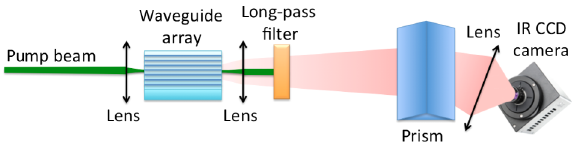
FIG. 6. Coincidences versus time delay between single-photon detectors: biphoton coincidences (red), events from uncorrelated photons (blue), and dark counts